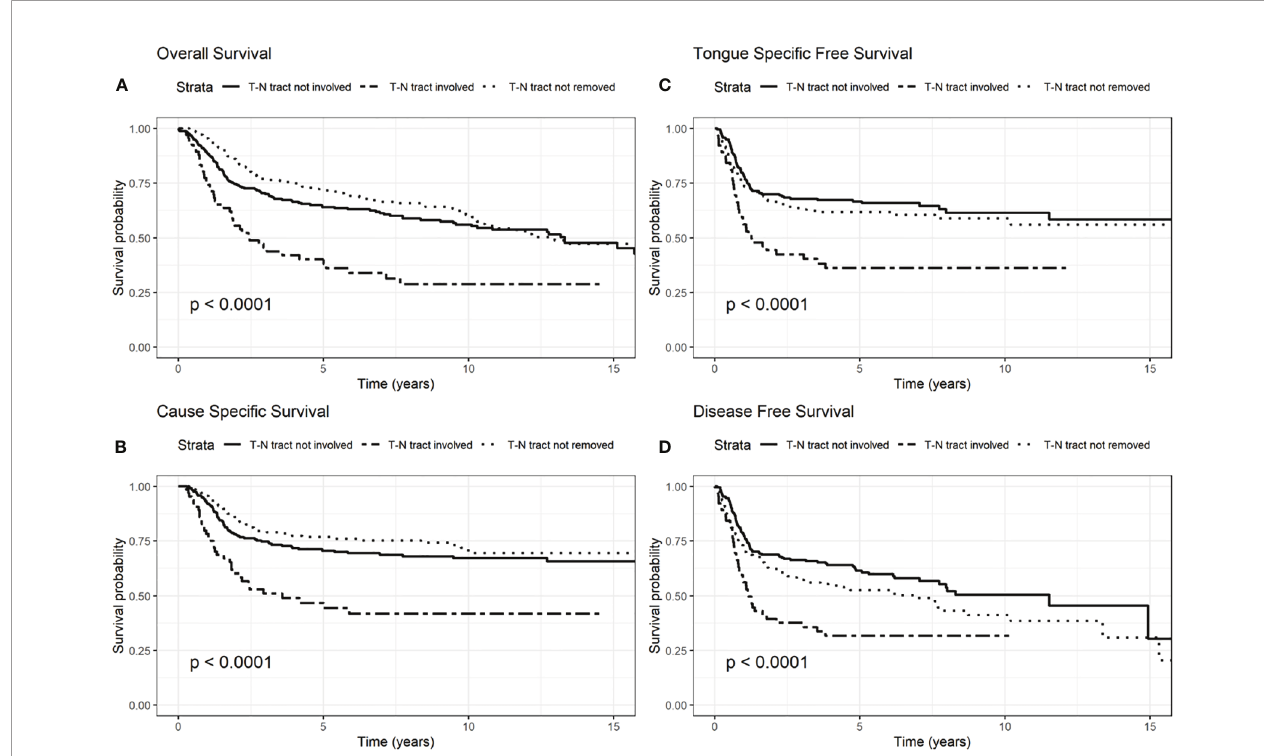
FIGURE 2 | Survival probability: overall survival (OS) (A) , cause-speci fi c survival (CSS) (B) , tongue speci fi c free survival (TSFS) (C) , disease-free survival (DFS) (D) according to T – N tract